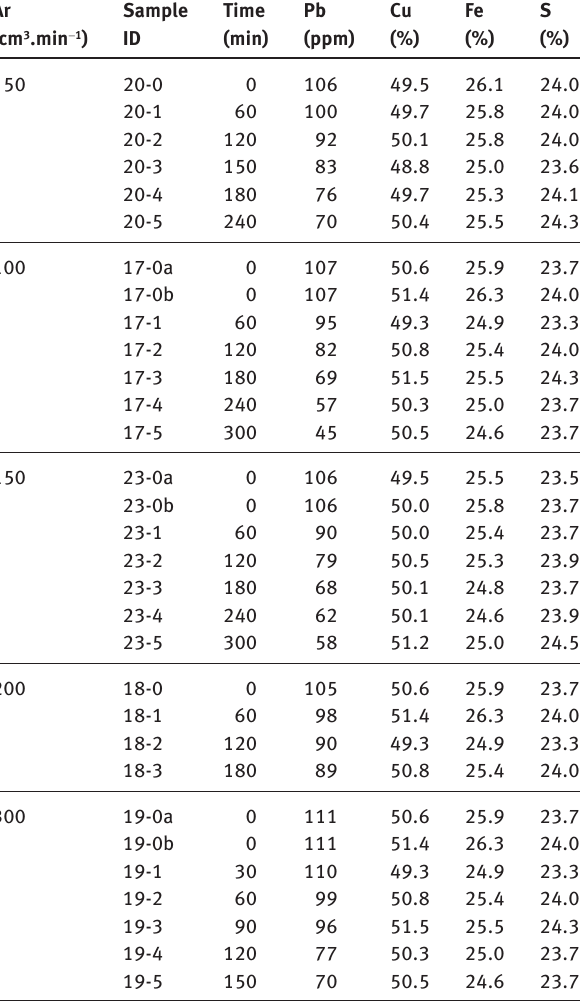
Table 2: Chemistry of the matte samples collected from the flow rate series of experiments at 1300 °C Ar Sample